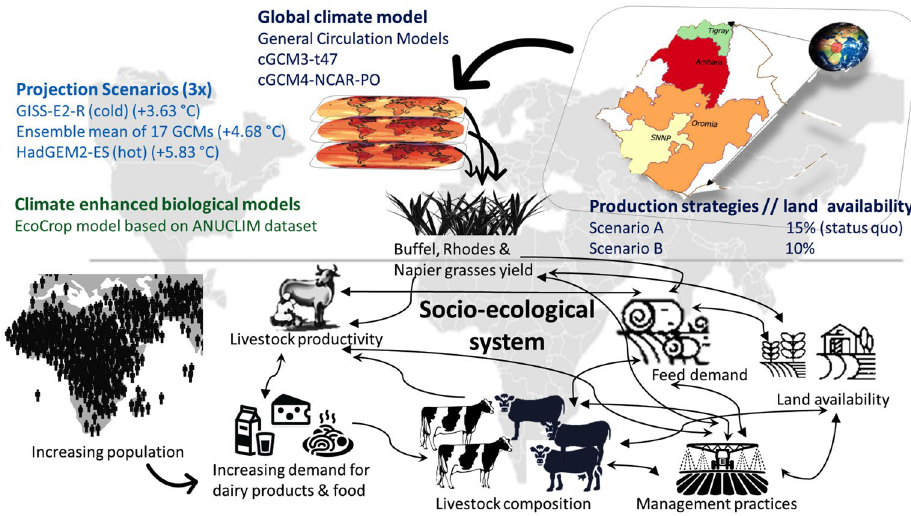
Figure 1. Elements of integrated modelling for evaluating climate impacts in 2050 on Buffel, Rhodes and Napier Grass contributions to cattle feed demand in Ethiopia as predicted by three future climate